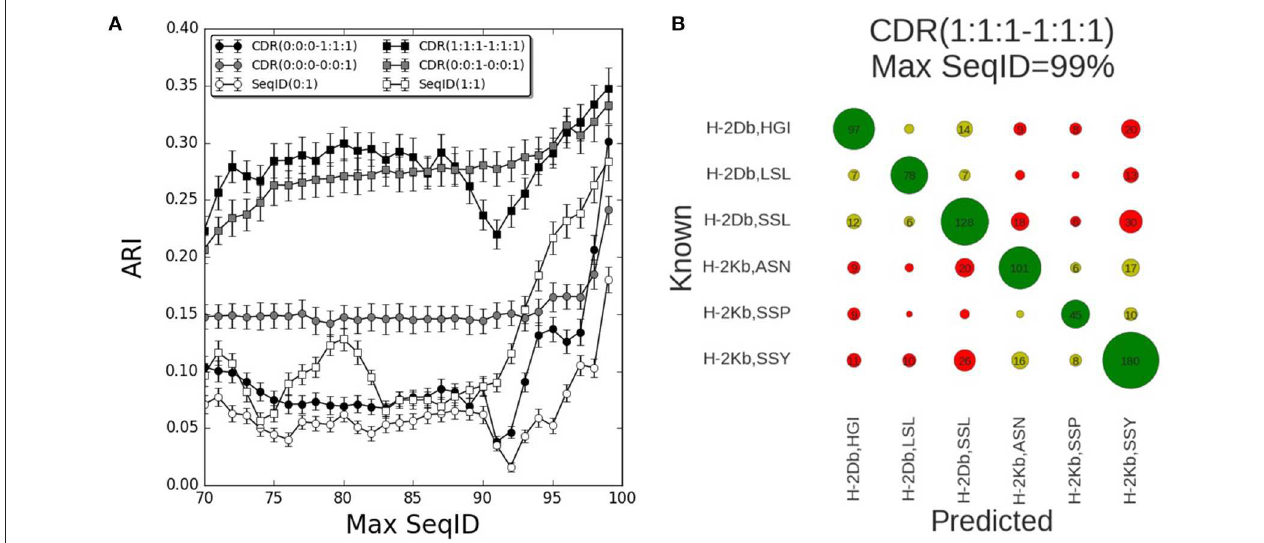
FIGURE 2 | Prediction performance for H-2 (mouse) benchmark. (A) TCR binding prediction performance as a function of Max SeqID for different similarities and weighting schemes. Increasing CDR similarities from using only CDR3 β , CDR(0:0:0–0:0:1) to all α and β CDR loops, CDR(1:1:1–1:1:1). When we use only β chain we filter sequences using SeqID(0:1) and when we predict using both chains we filter sequences using SeqID(1:1). Error bars are estimated using bootstrap with 1,000 iterations on the final prediction outcome. (B) Confusion matrix of the prediction outcome used for ARI calculation. Predictions performed using the model with equal weights for each CDR loop [model CDR(1:1:1–1:1:1)] using a Max SeqID TCR similarity threshold of 99% have an ARI value of 0.35. Rows and columns are labeled with the MHC mouse allele and the first three letters of the peptide. Green circles are correctly predicted TCRs, light green circles represent correctly predicted MHC but wrong peptide, and red circles are for wrong MHCs. Numbers < 5 are omitted for